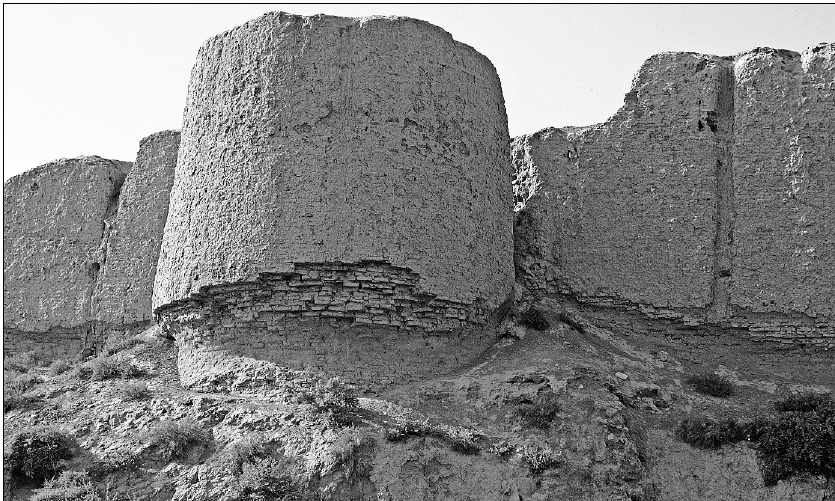
Figure 3 A corner tower of the Timurid city of Abdullah Khan Kala, built early in the fifteenth century AD , showing the erosion at the base of the walls caused by rising water and by the